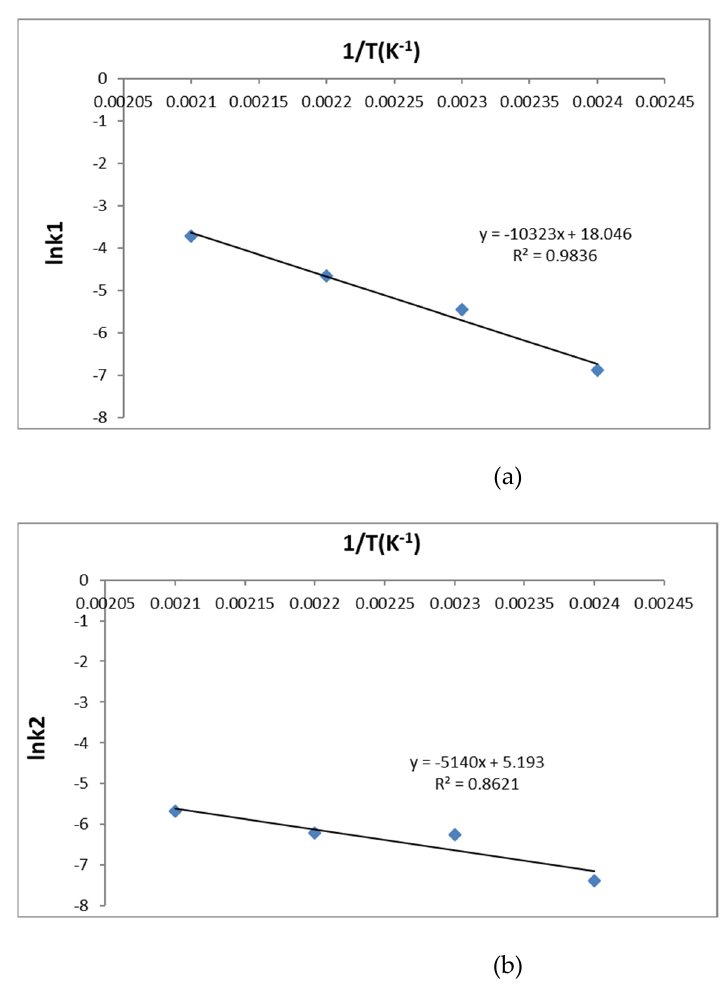
Figure 8. Determination of rate constants for cellulose hydrolysis using H-ZSM-5 catalyst in [BMIM] Cl. (a) plot of ln (k) vs. 1/T for K 1 , (b) plot of ln (k) vs. 1/T for K 2